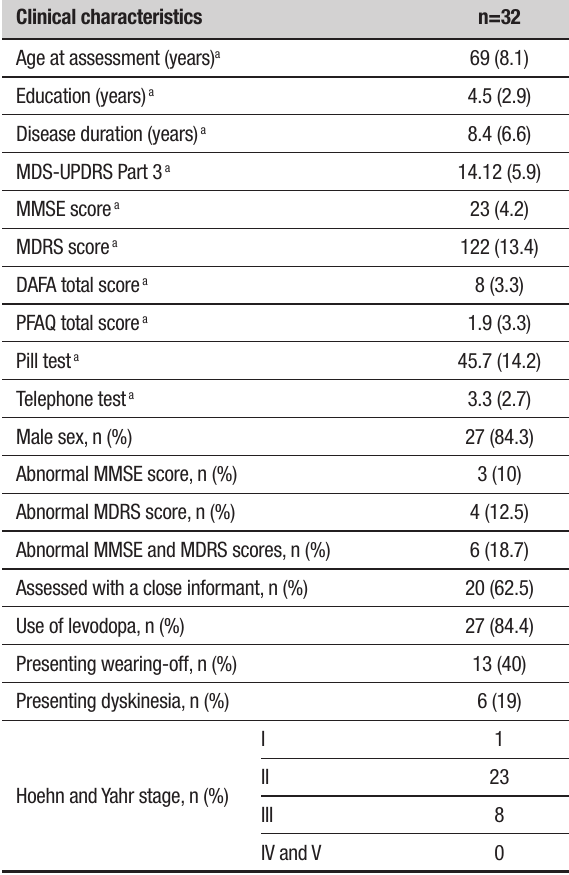
Table 1. Clinical characteristics of PD patients with suspected mild dementia. Clinical characteristics